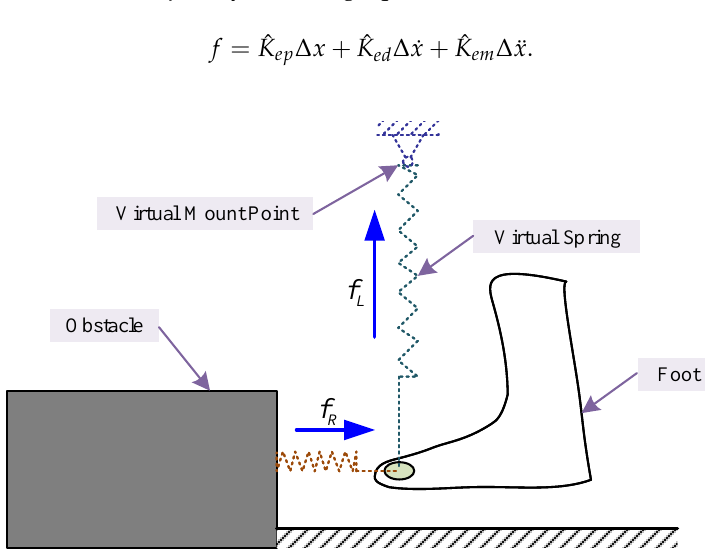
Figure 1. Illustration of virtual forces. f L and f R are lifting force and repulsive force generated from virtual springs, respectively. The forces only take effect on a given